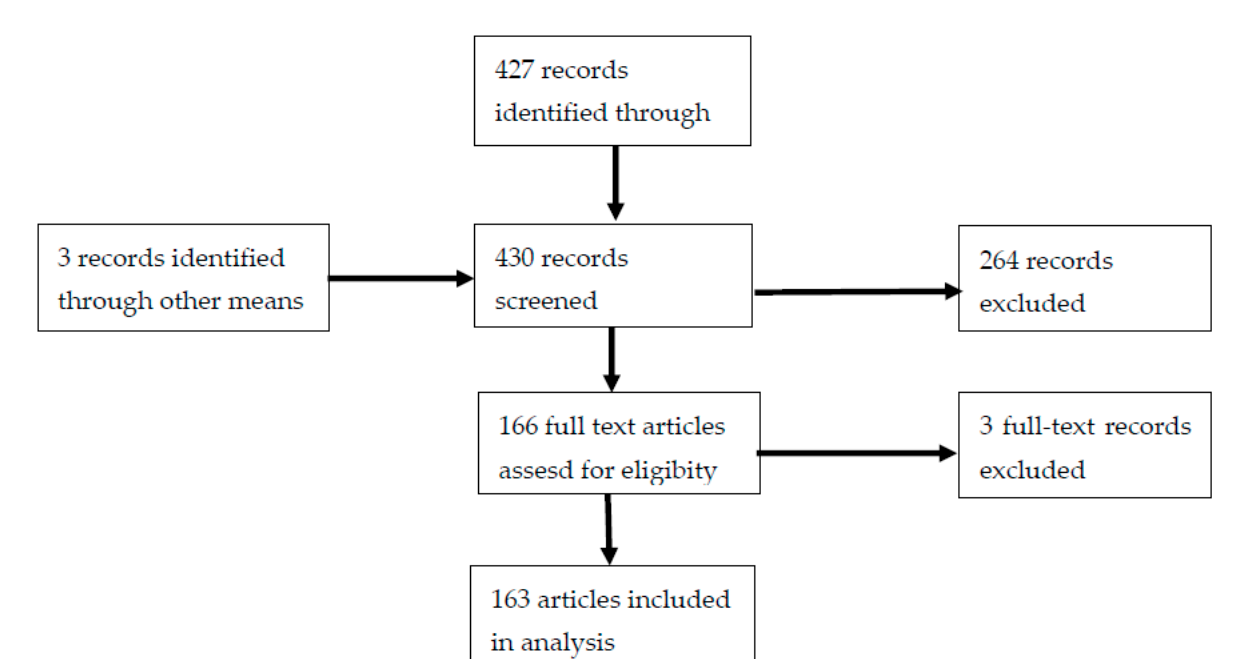
Figure 1. Preferred Reporting Items for Systematic Reviews and Meta-Analyses (PRISMA) study flowchart for our identified articles. Table 1. Summary of characteristics identified across included papers.